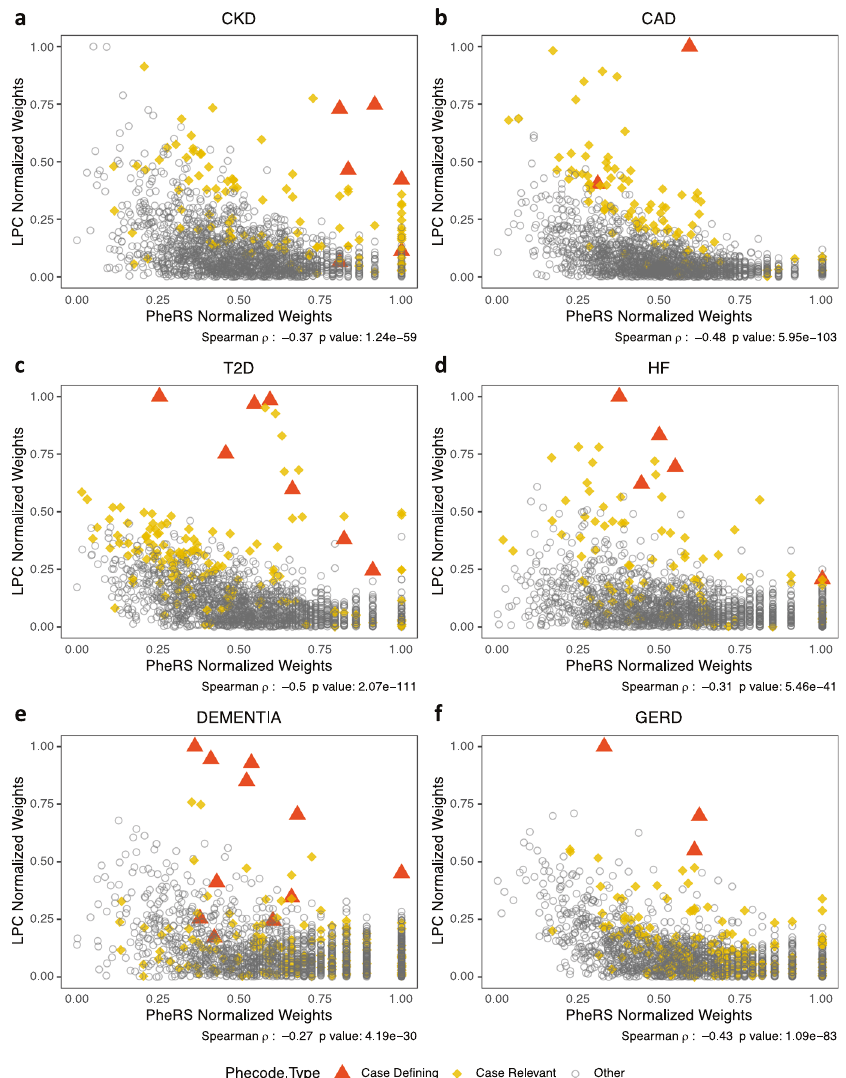
Fig. 5 Weights for all phecodes used to build PheRS and LPC for six phenotypes. Scatter plots of weights for a CKD (cases including G1, G2, G3a/b, and G4 stages), b CAD, c T2D, d HF, e Dementia, and f GERD. The weights for the case de fi ning and pre-selected phecodes are